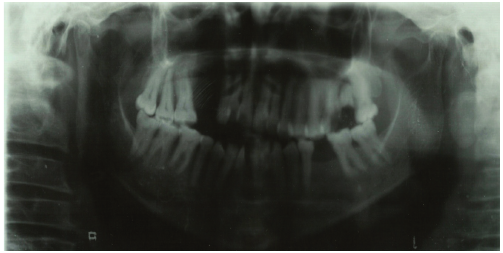
Figure 2: OPG showing destructive radiolucent lesion of right maxilla.